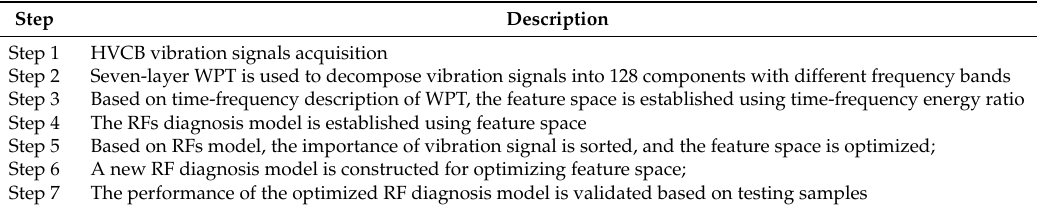
Table 1. General procedure of HVCB fault detection by the proposed method.